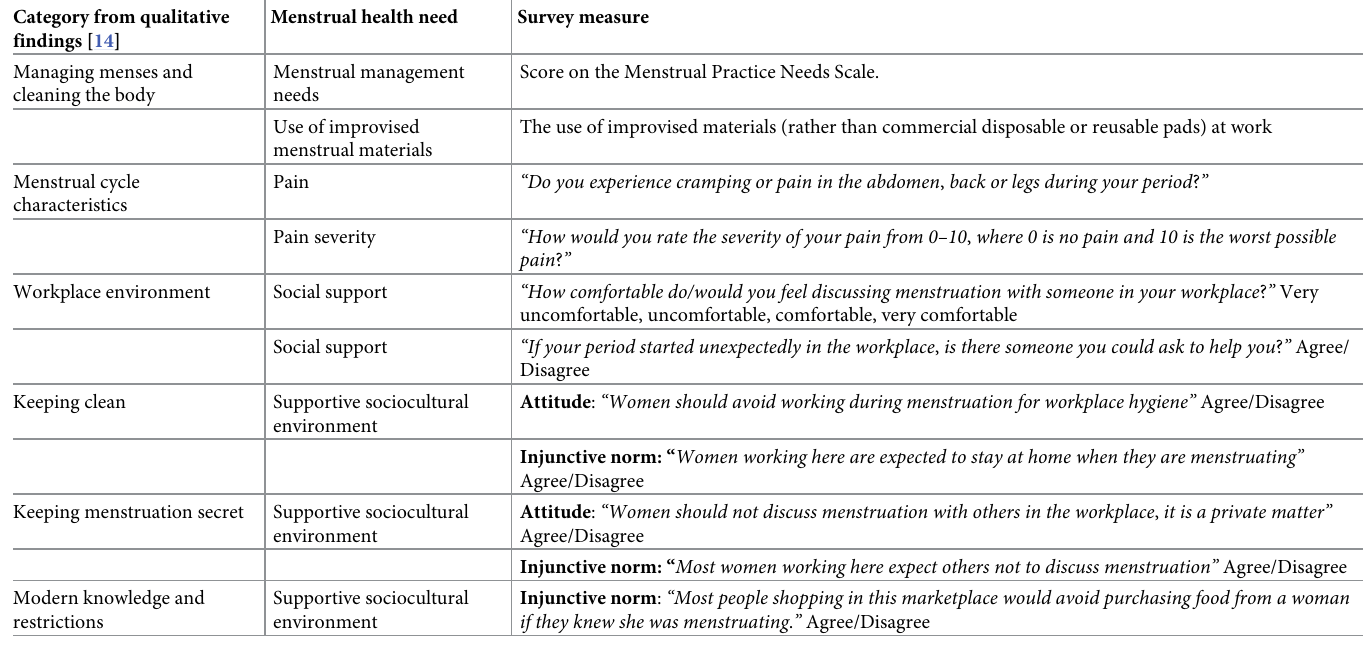
Table 1. Qualitative findings, identified unmet menstrual health needs, and corresponding survey measures used in the present